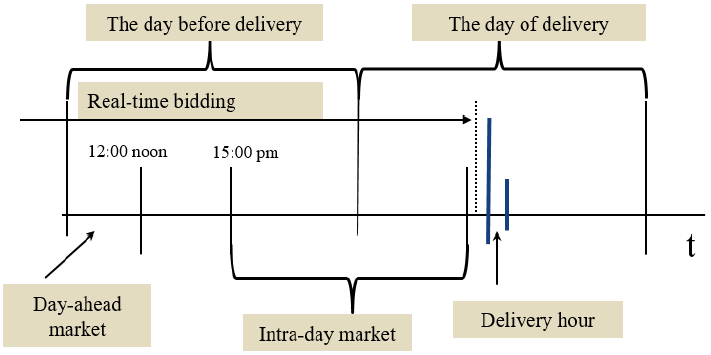
Figure 1. Time line for physical